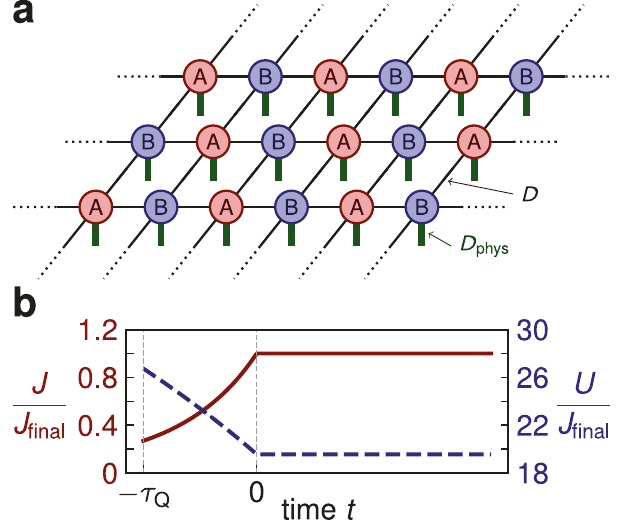
Fig. 1 Setup for numerical simulations of quench dynamics. a Schematic fi gure of in fi nite projected entangled pair state (iPEPS) with a two-site unit cell. Sublattice sites are represented by A and B . A rank- fi ve tensor at each site is represented as a circle with four thin lines and one thick line. The former lines correspond to the virtual degrees of freedom with the bond dimension D , while the latter line corresponds to the physical degrees of freedom with the dimension of the local Hilbert space D phys . The wave functions become more accurate as D increases. b Time dependence of the hopping J (a red solid line) and the onsite interaction U (a blue dashed line) with a fi nite-time quench. The parameter U / J is varied from ~99.4 to ~19.6 for − τ Q < t < 0 with τ Q being a fi nite quench time. In the case of a sudden quench, we discard the region − τ Q < t <